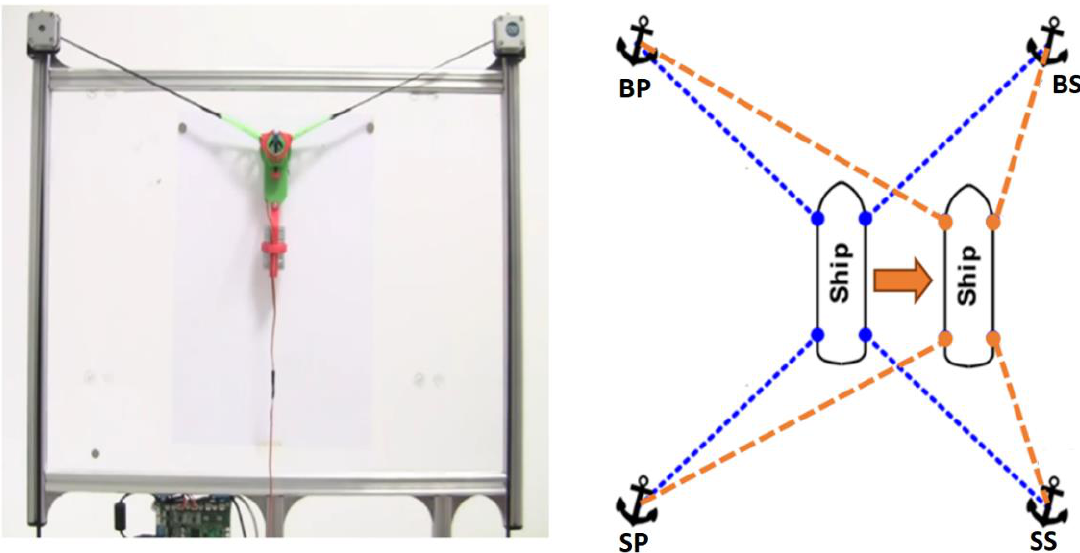
Figure 1. Comparison of a vertical plotter [18] with anchor-based positioning.